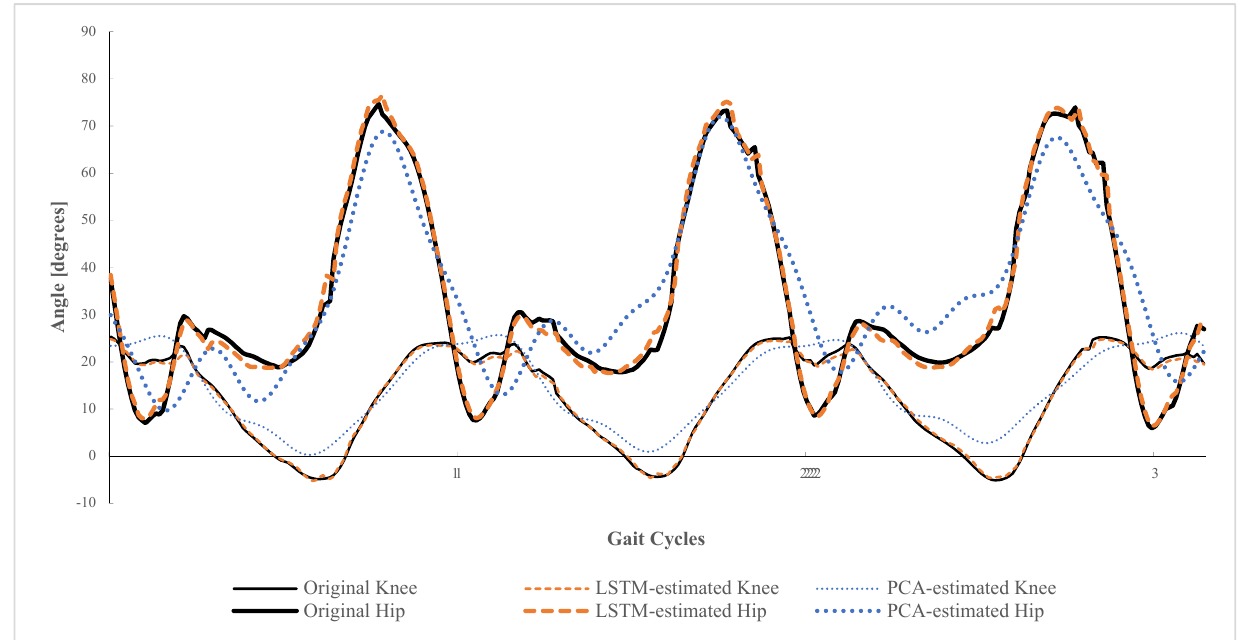
Figure 3. Estimated hip (thicker curves) and knee angles (thinner curves) by PCA (orange curves) and LSTM (blue curves) based on interlimb